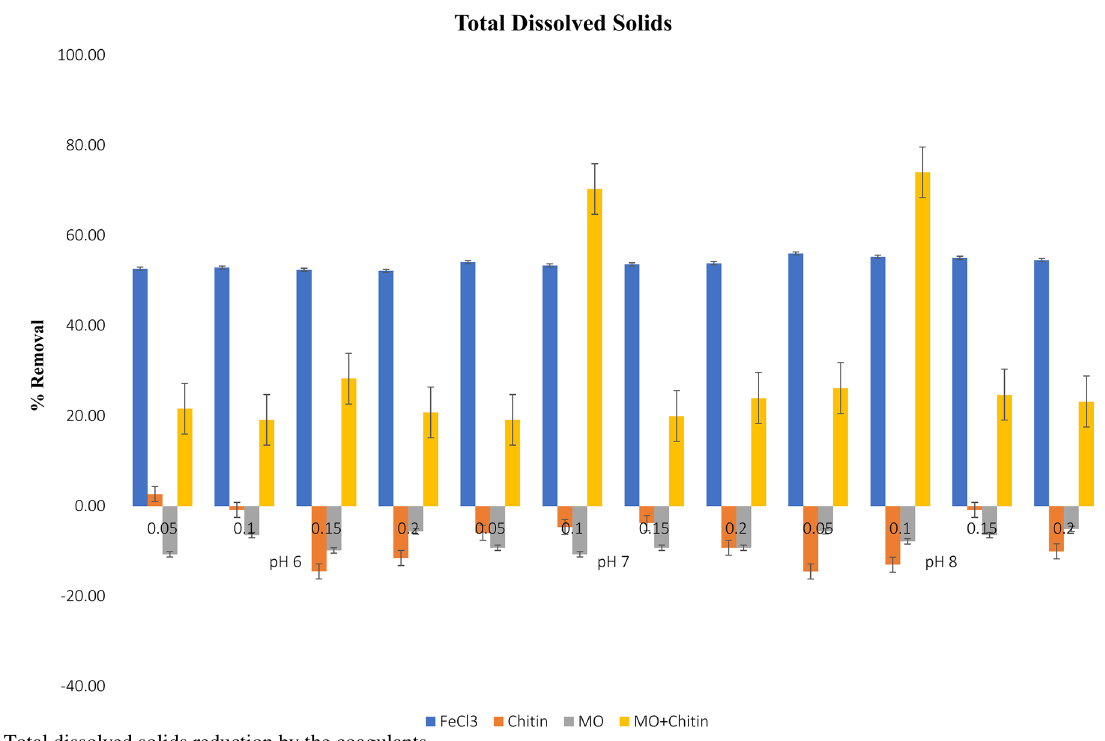
Fig. 3 Total dissolved solids reduction by the coagulants